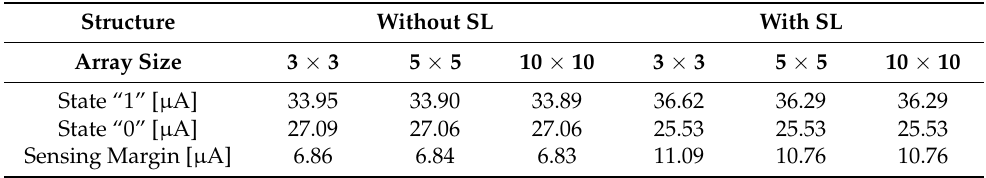
Table 6. Current values of states and sensing margin in the with- and without-SL cases according to array